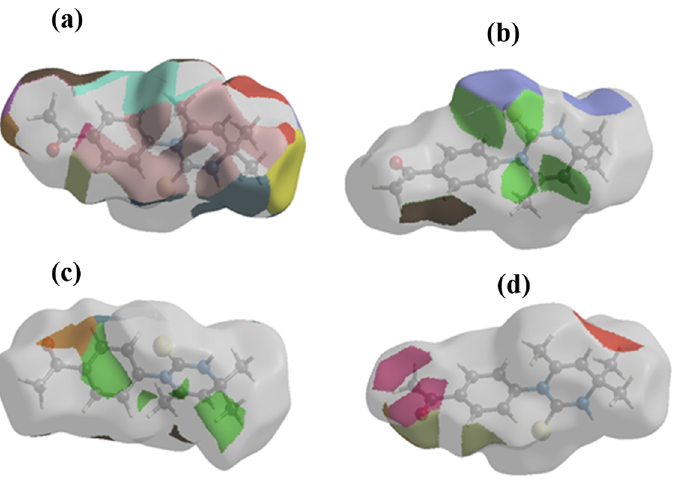
Figure 6. The Hirshfeld surface representations ( a ) H · · · H, ( b ) H · · · S/S · · · H, ( c ) H · · · C/C · · · H and ( d ) H · · · O/O · · · H interactions (discussion is given in supplementary file). Table 4. Geometric parameters of the selected compound 4 .